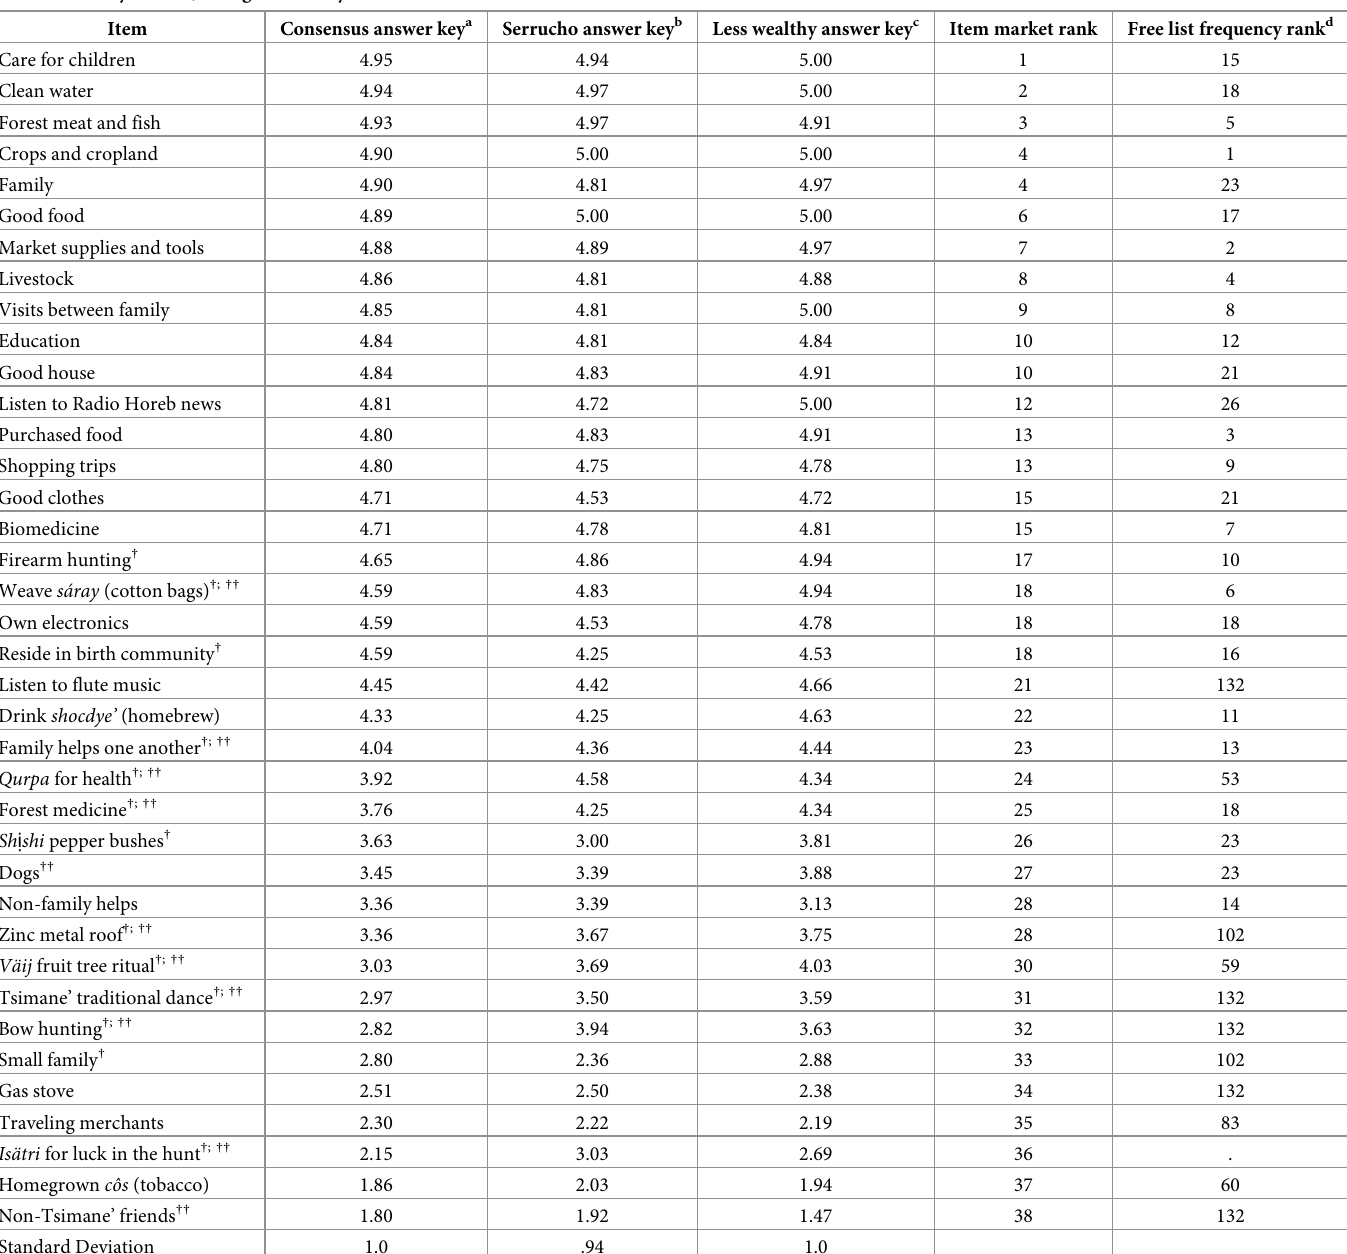
Table 3. Lifestyle items, rating answer keys and